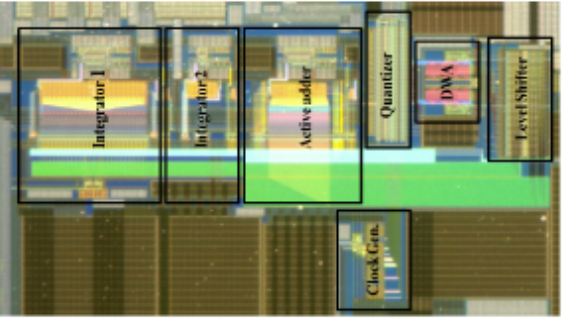
Figure 11. Die micrograph.